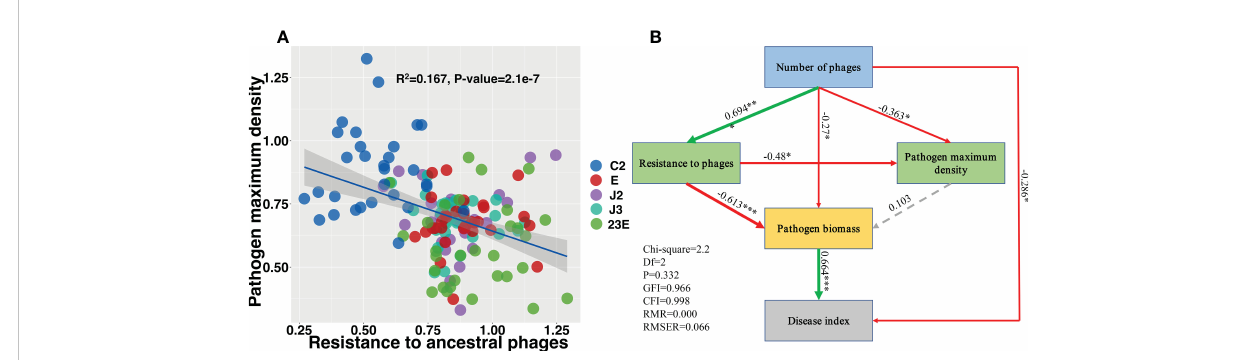
FIGURE 6 Evolved pathogen maximum density negatively correlated with resistance to ancestral phage (A) . Structural equation modeling showing the effects of phages, pathogen to phage resistance, and pathogen maximum biomass on the disease index (B) . Green lines indicates positive effects while red lines indicates negative effects. Dashed gray lines indicates insigni fi cant effects. The width of the arrows indicates the strength of signi fi cant standardized path coef fi cients and the signi fi cance levels of each predictor are shown as *( P < 0.05), **( P < 0.01), and ***( P < 0.001). C2, Xoo strain alone; J2, Xoo phage J2; J3, Xoo phage J3; E, Xoo phage E; 23E, Xoo phages